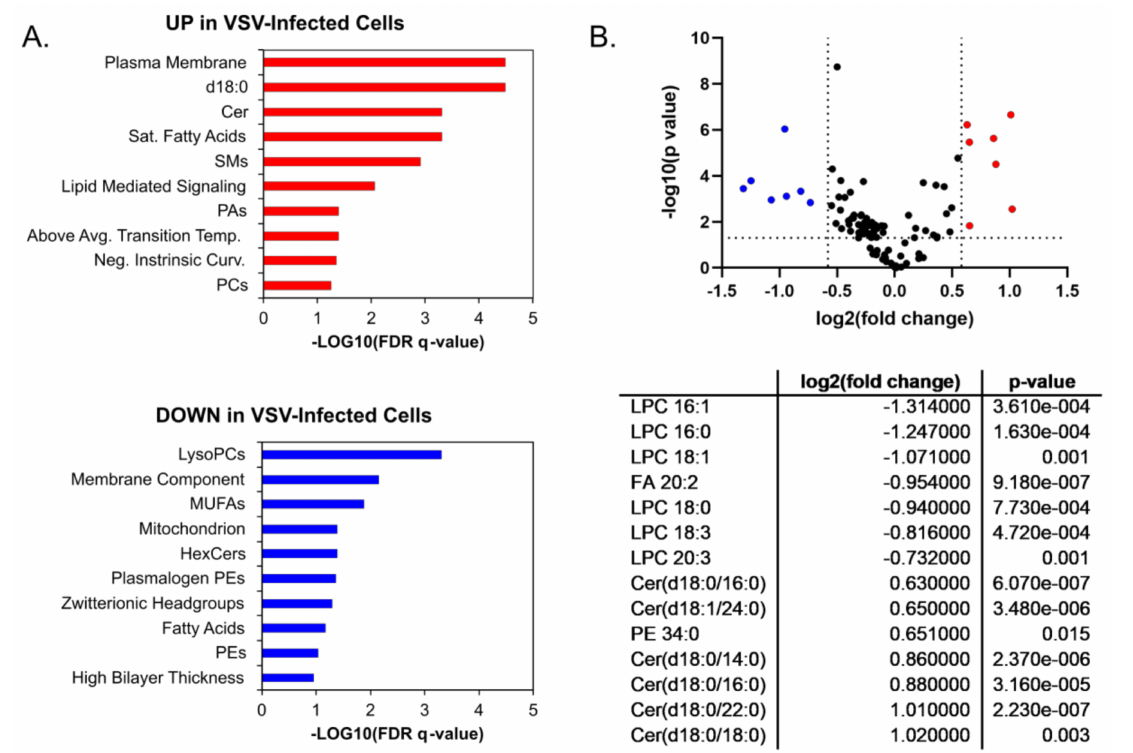
Figure 4. Ontology and significantly altered lipids. Enrichment ontology analysis performed in LION/web for ( A ) Upregulated lipids (in red) and downregulated lipids (in blue); ( B ) Lipid changes displayed according to fold change and p-value threshold significance cutoffs of 1.5 and 0.05, re- spectively. P-values were determined by Student’s t -test (two-tailed, equal variance). Significantly upregulated (red) and downregulated lipid species (blue) are listed in the table in the lower